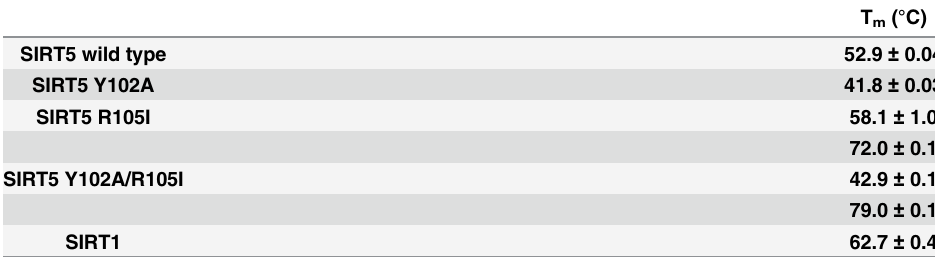
Table 1. Melting Temperatures of SIRT5 Variants as well as